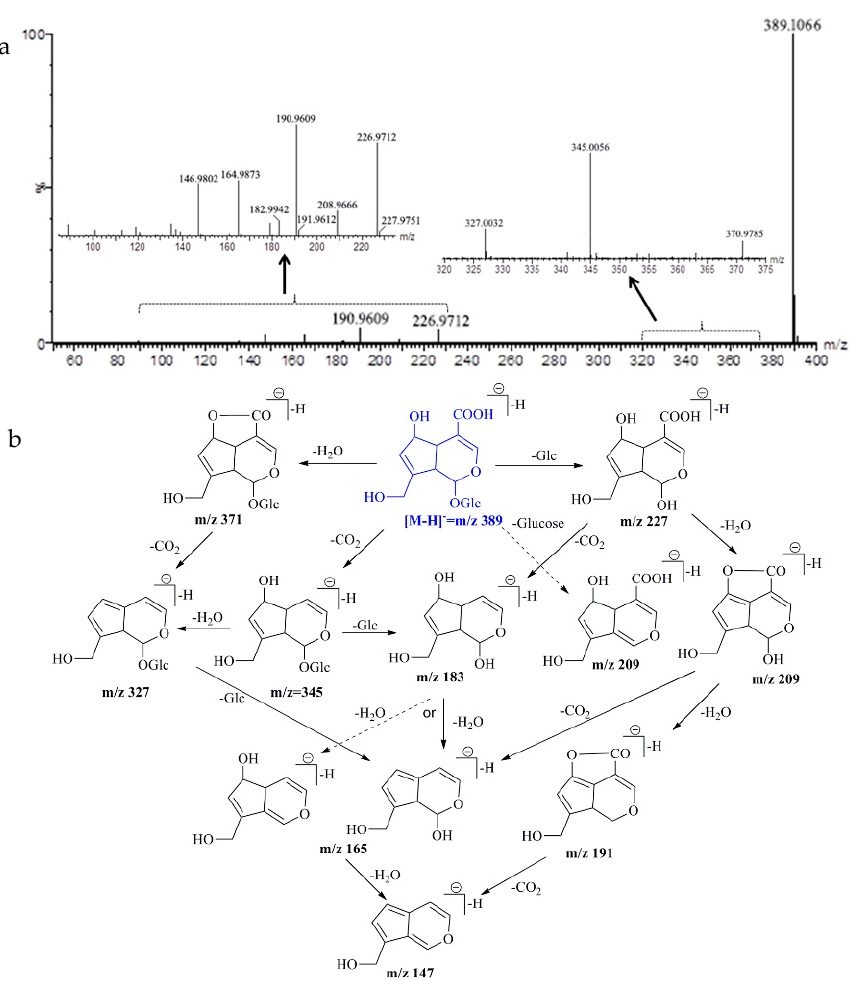
Figure 4. MS/MS spectra ( a ) and the proposed fragmentation pathway ( b ) of deacetyl asperulosidic acid.